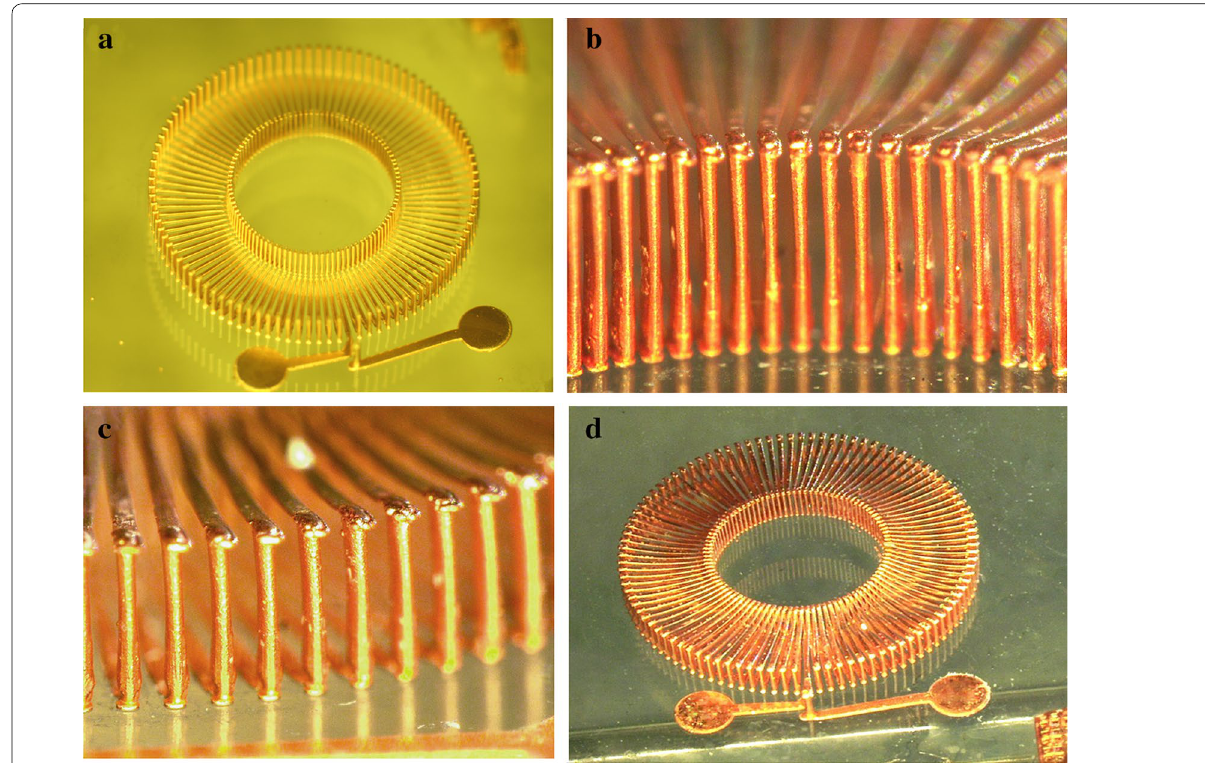
Fig. 9 100-turn toroidal microinductor, a bottom and vertical winding, outer diameter is 8 mm; b inner vertical winding, height is about 1000 µm; c outer vertical winding, the height is about 1000 µm; and d a batch fabrication of 100-turn toroidal